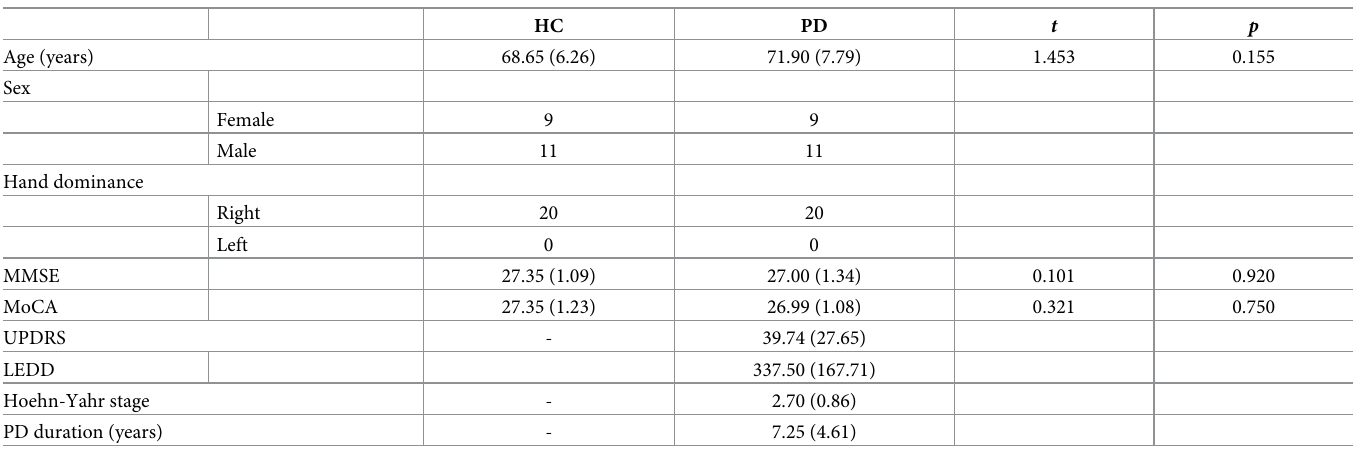
Table 1. Participant